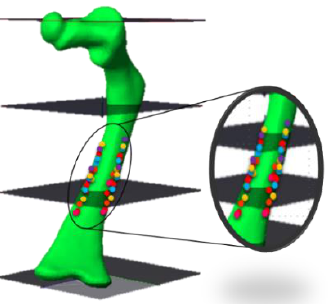
Figure 3. Obtaining HU values in different slices and areas.